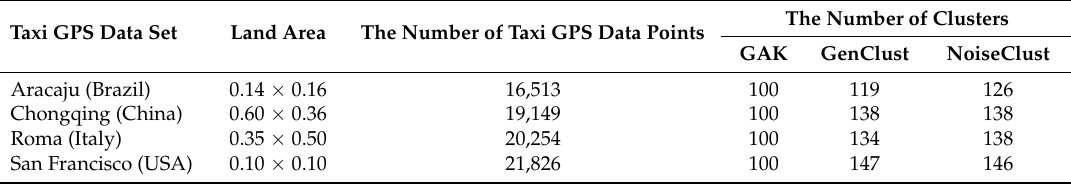
Table 1. The experimental datasets of taxi GPS